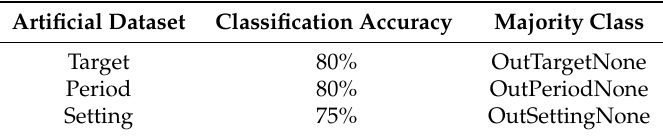
Table 3. ZeroR baseline generator.